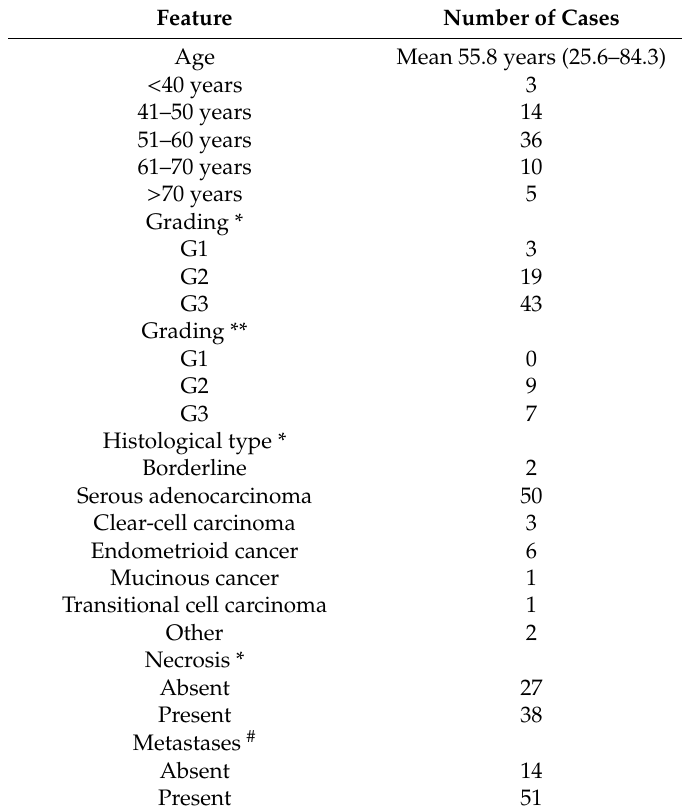
Table 1. Pathomorphological characteristic of the patients included in the present